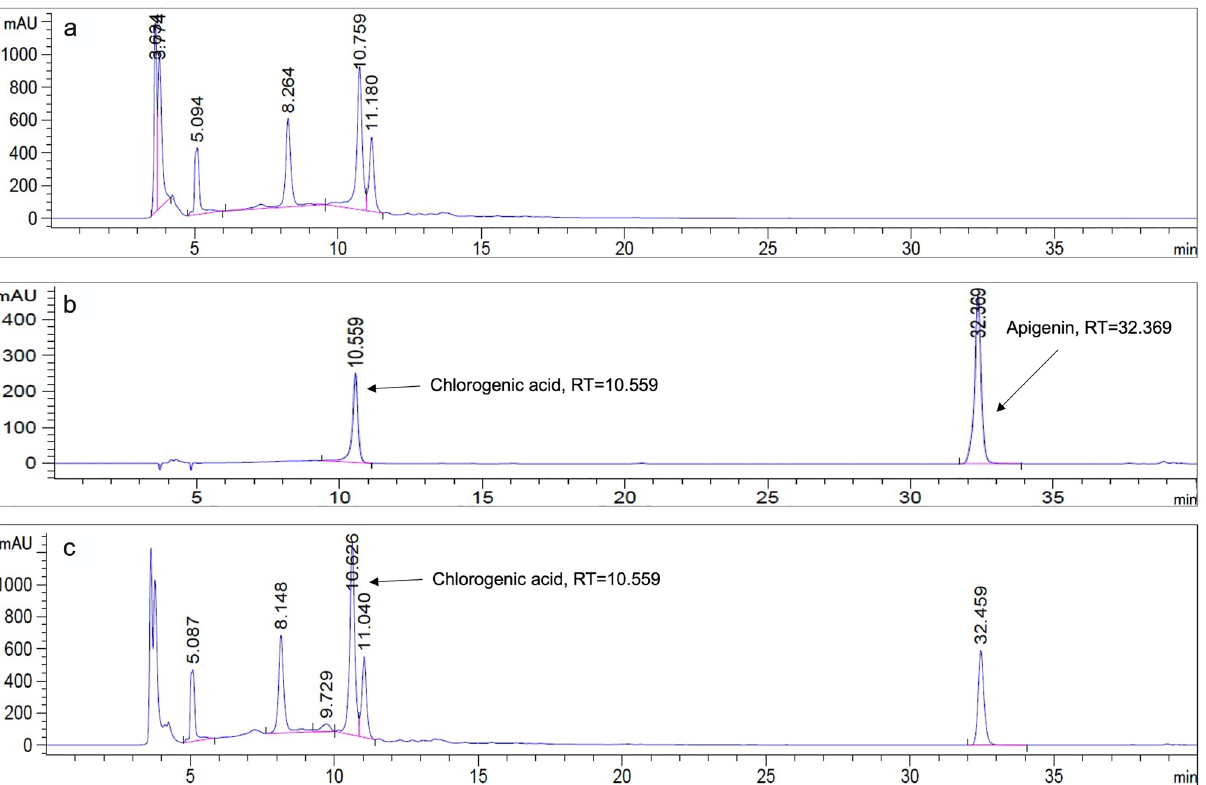
Figure 1. HPLC chromatograms of ( a ) FDLE, ( b ) the standard of chlorogenic acid and apigenin and ( c ) FDLE with